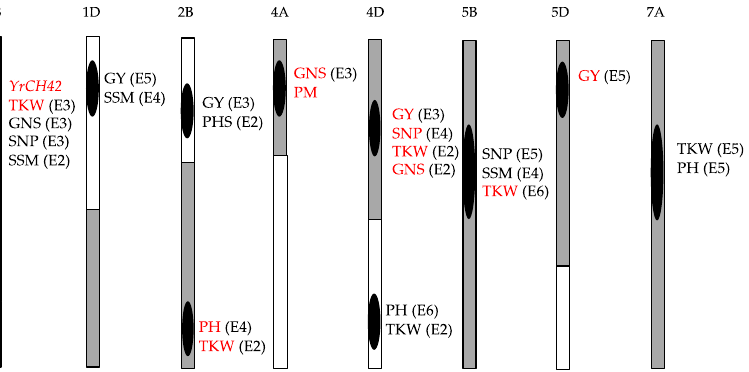
Figure 7. Genotypic patterns of Chuanmai 104 and yield-related QTLs on seven chromosomes. GY, grain yield; SSM, spike number per square meter; TKW, thousand-kernel weight; GNS, grain number per spike; SNP, spike number per plant; PH, plant height; PHS, pre-harvest sprouting resistance; PM, powdery mildew resistance. Red capital letters indicate that a QTL allele-increased phenotypic value was from the parent Chuanmai 42, and chromosome intervals in gray indicate the genomic regions from Chuanmai 42. The numbers in parentheses represent the number of environments in which each QTL could be